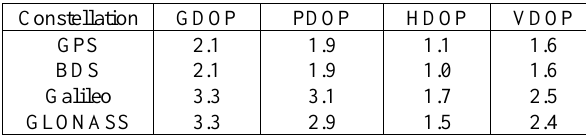
Table 4 . The average DOP of different constellations during the one-hour static experiment.